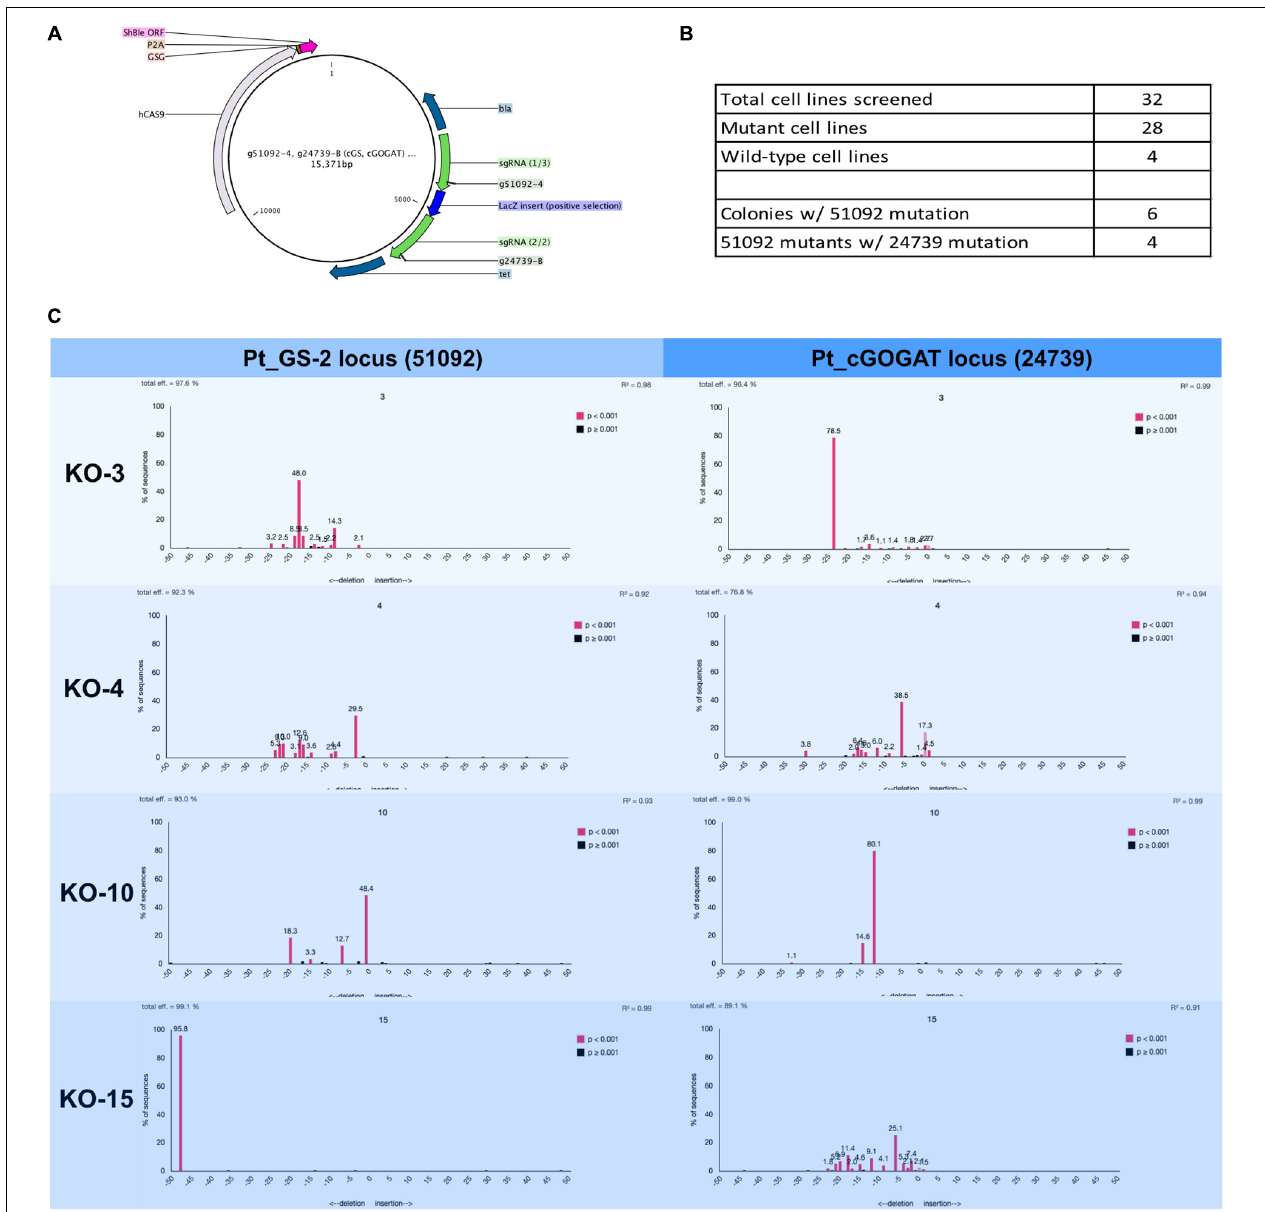
FIGURE 4 | Two-gene mutagenesis of the genomic target glutamine synthetase 2 (GS-2, Phatr3_J51092) and the chloroplast localized glutamate synthase (cGOGAT, Phatr3_J24739). (A) The assembly Cas9-sh ble:sgRNA episome plasmid map with two sgRNA expression cassette (g51092-4 and g24739-B, green arrows). (B) A total of 28 phleomycin-resistant colonies and 4 wild-type cell lines were genotyped for mutations at both target loci. The screening was performed iteratively where all 32 cell lines (mutants and wild-types) were first screened for mutation at the g51092-4 target locus then candidate GS-2-KO cell lines were screened for mutation at the g24739-B locus. 6/28 cell lines exhibited Cas9 activity in 51092 and 4/6 GS-2 mutants exhibited Cas9 activity in 24739. The genotyping results for all cell lines was performed this way ( Supplementary Tables S3, S4 ). (C) Four knock-out cell lines (3, 4, 10, and 15) and their associated TIDE charts show the diversity of mutagenesis at both